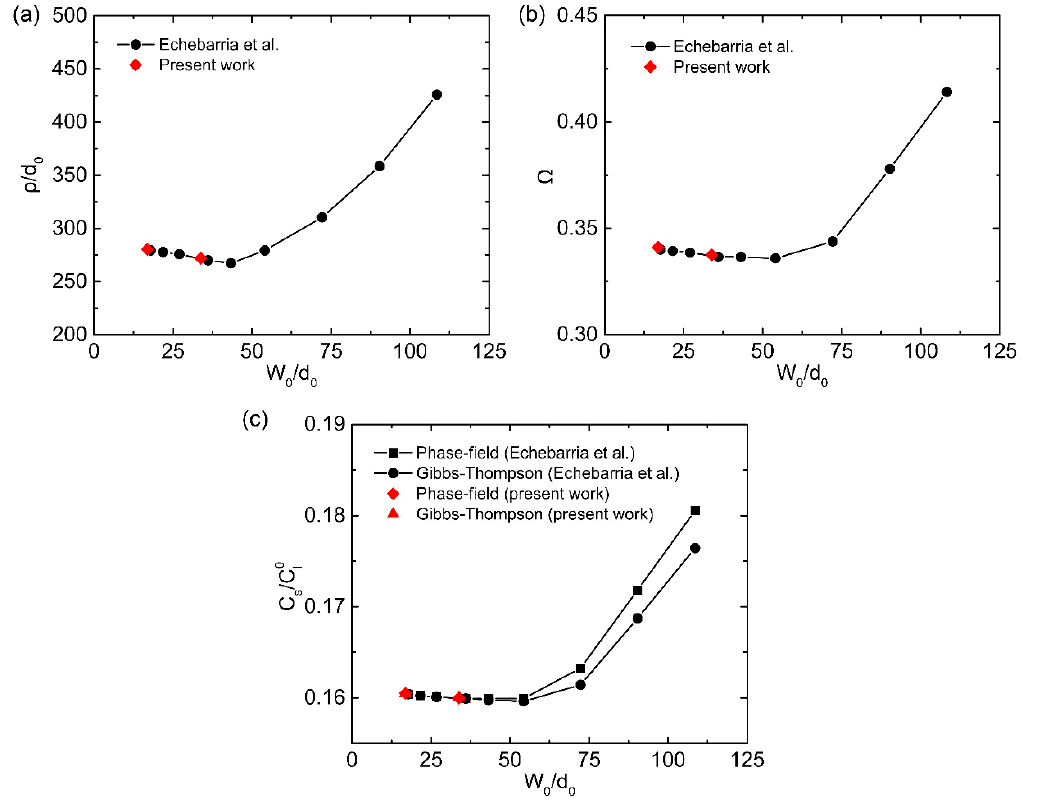
Figure 5. Comparison of various quantities associated with steady-state cell shapes: ( a ) tip radius ρ , ( b ) dimensionless tip undercooling Ω , and ( c ) solid concentration in the center of the cell.